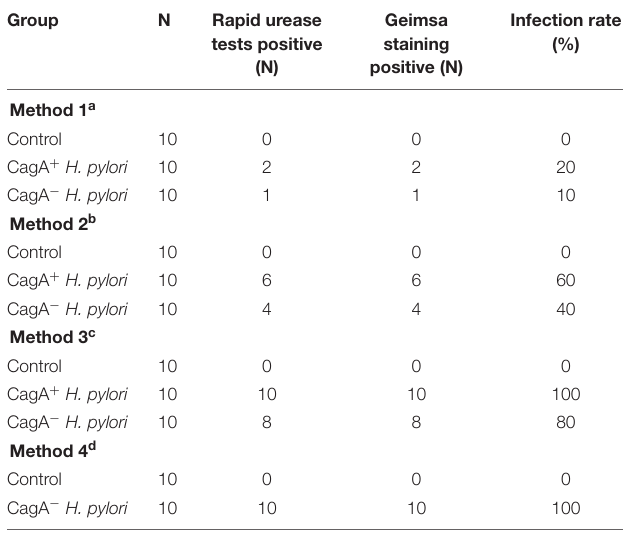
TABLE 1 | Infection rate of CagA + Helicobacter pylori and CagA − H. pylori 1 week after last intragastric gavage.